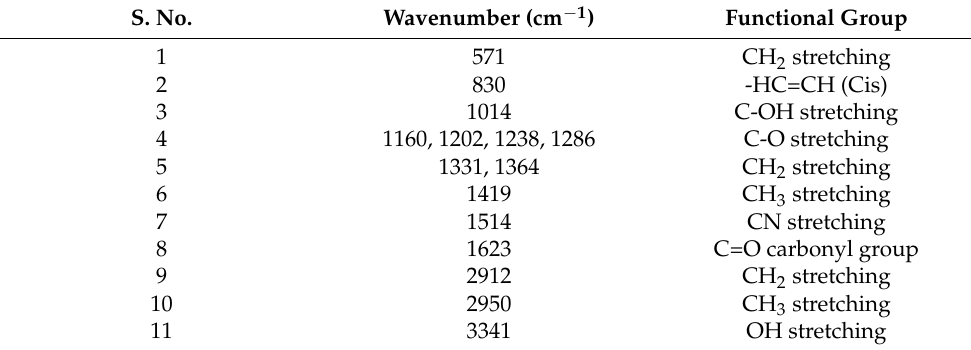
Table 4. Functional group observed in FTIR spectra of turmeric samples.